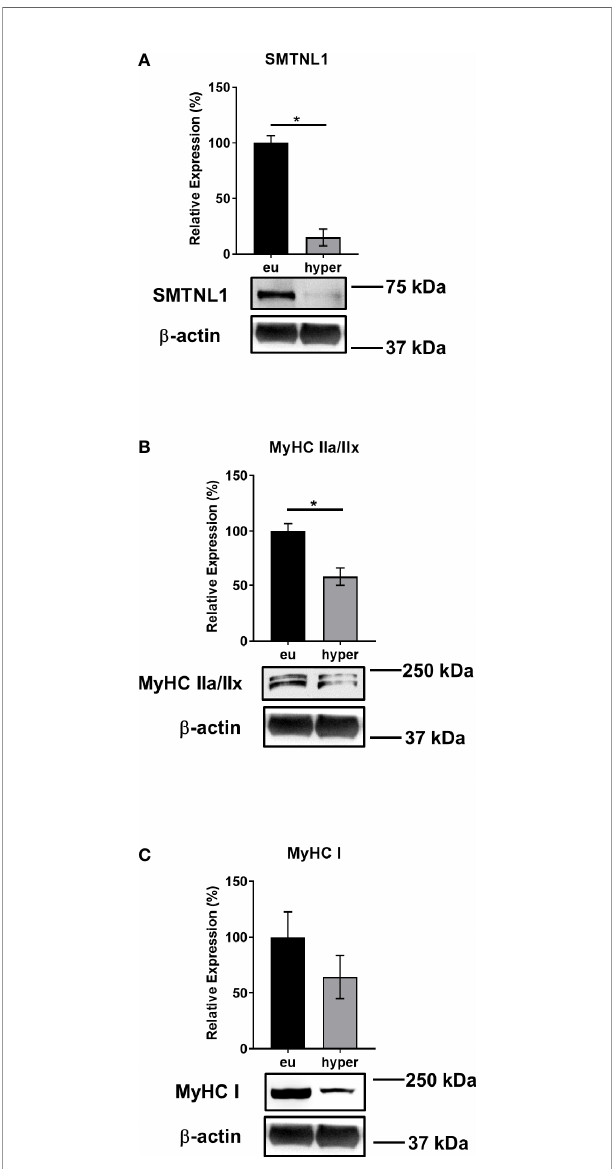
FIGURE 3 | SMTNL1, MyHC IIa/IIx, and MyHC I Expression during Hyperthyroidism. Proteins from skeletal muscle biopsies were separated by SDS- PAGE followed by Western blot analysis using anti-SMTNL1 (A) , anti-MyHC IIa/ IIx (B), and anti-MyHC I (C) antibodies. Values represent n=3, mean +/- SEM. Bar charts display the expression levels of SMTNL1, MyHC IIa/IIx, and MyHC I in hyperthyroid samples normalized to their euthyroid counterparts. Groups were compared using unpaired two-tailed t-tests, p < 0.05